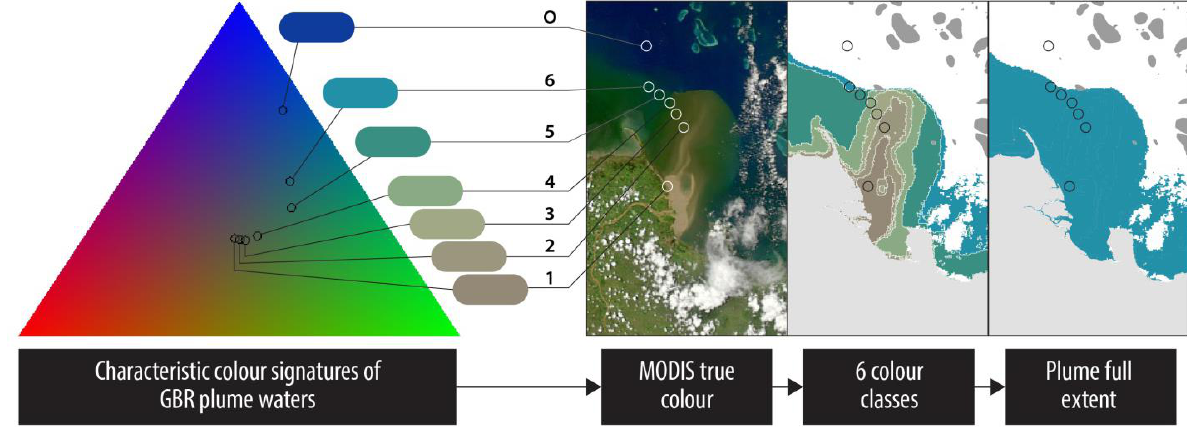
Figure 5. Triangular colour plot showing the characteristic colour signatures of the Great Barrier Reef river plume waters (six plume colour classes) in the Red-Green-Blue space. A method has been developed to map the GBR river plumes and the different water masses inside the river plumes using these characteristic signatures and a supervised classification of MODIS true colour data